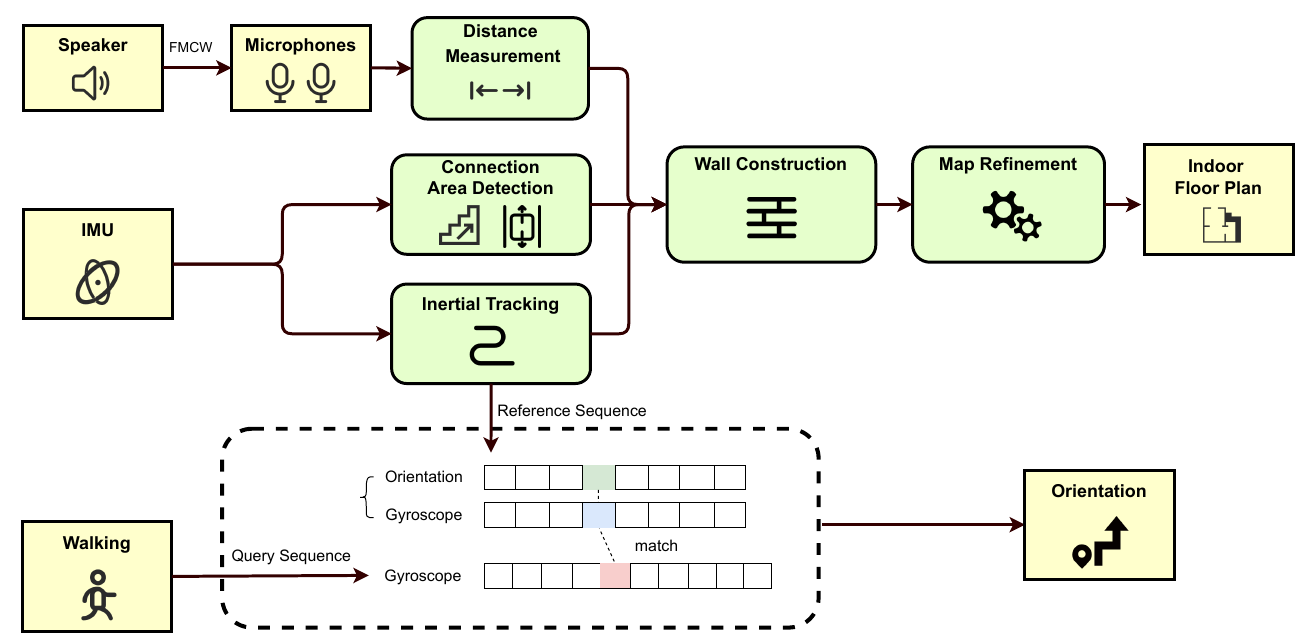
Figure 1. Overview of BatMapper-Plus. Distance measurement: we use smartphone’s speaker to emit FMCW sound signals, and use microphones to receive the signals returned by the side wall, then we calculate the distance between the smartphone and the wall according to the sound propagation time. Inertial tracking: we use IMU readings to estimate the user’s walking trajectory and detect connection areas among different levels. Sequence matching: the IMU record stored in the mapping process is used as the reference sequence, and we devise a DTW algorithm to match the reference sequence with new user’s walking sequence to provide fine-grained navigation